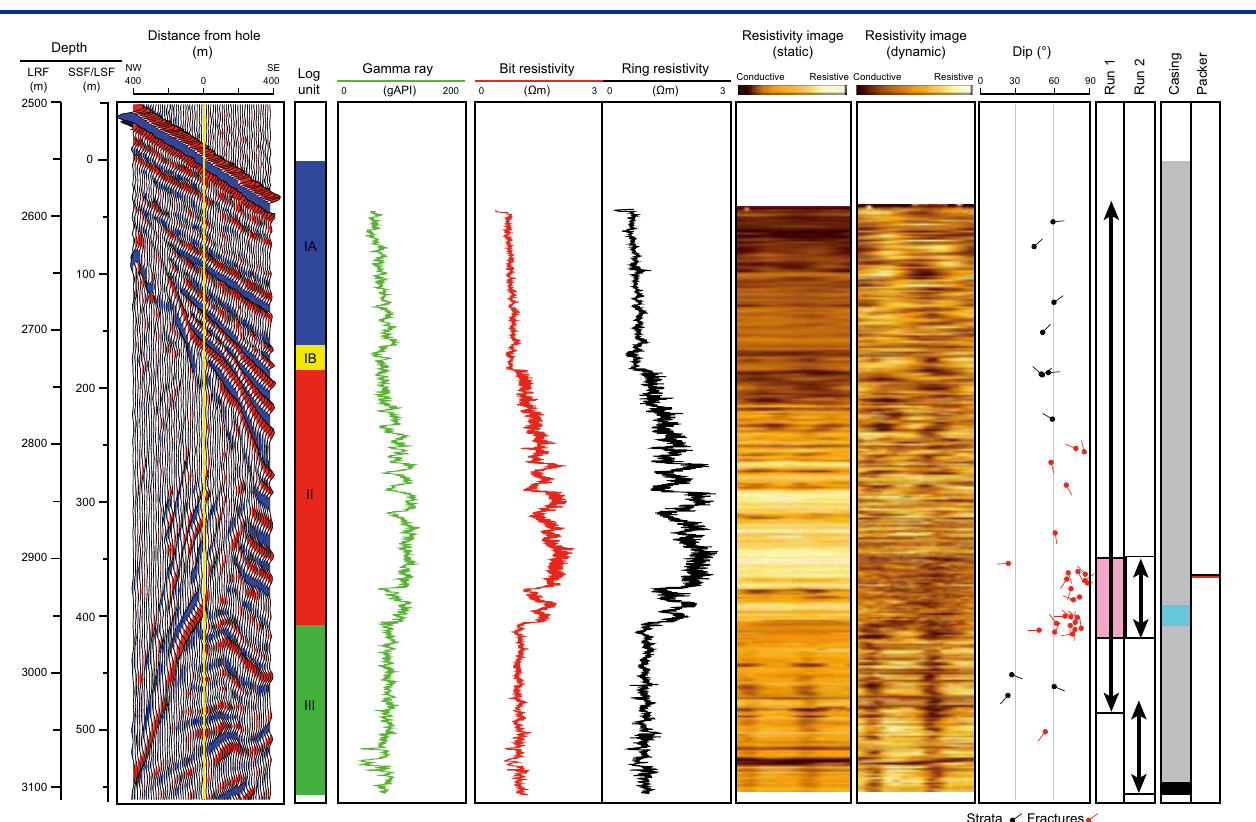
Figure 7. Site summary diagram for Site C0010 across the shallow megasplay fault zone showing LWD/MWD data. Vertical black arrows indicate sections of borehole logged during the two logging runs (section in pink reamed and relogged during logging Run 2). Key elements of casing and hole suspension for observatory instrument installation relative to the position of the fault zone are shown at right: blue = casing screens; black = casing shoe; thin black line = retrievable packer; thin red line = smart